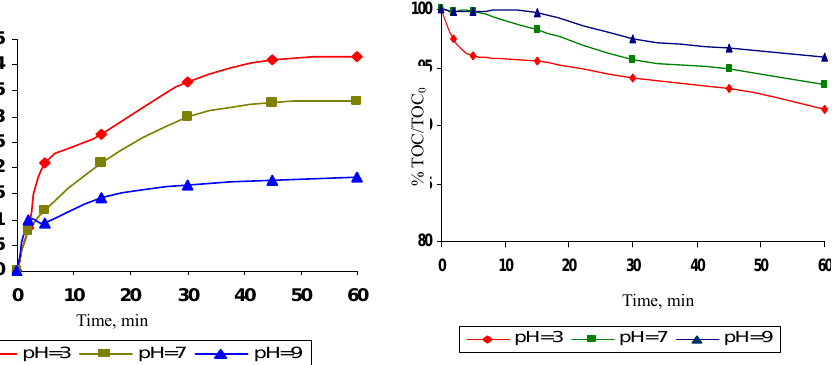
Figure 6. Released nitrate ion during the catalytic ozonation of 4NCB at different pHs. [ZnO] = 300 mg/L; [O